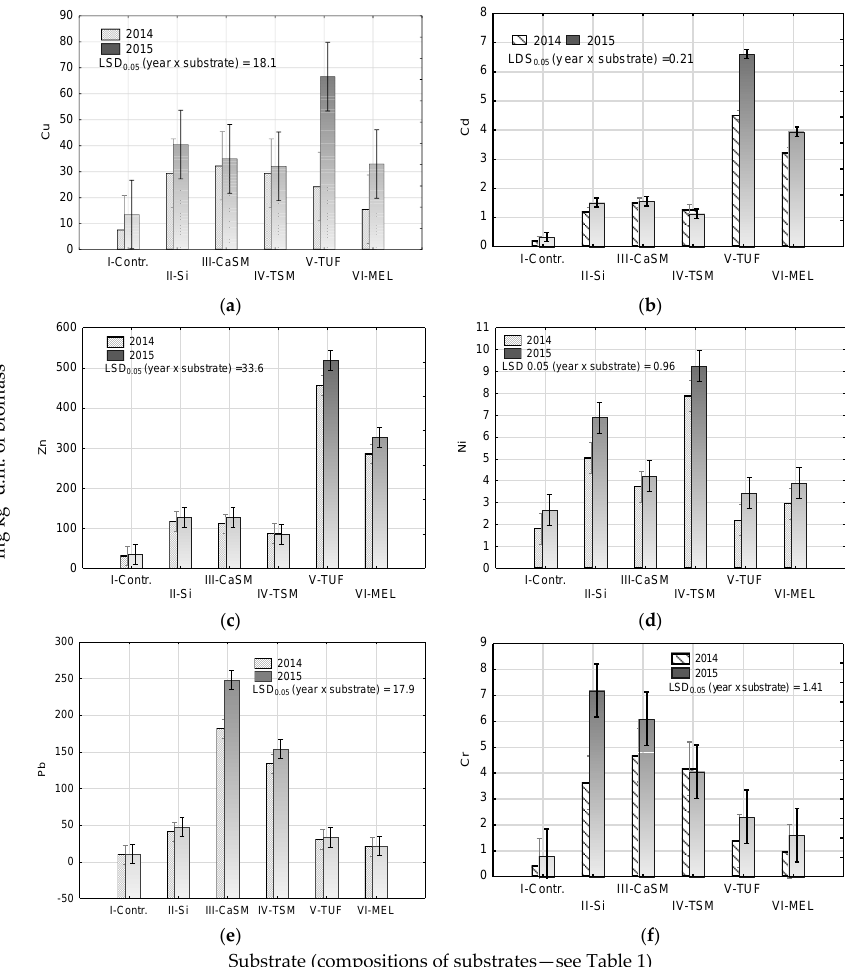
Figure 3. Trace element ( a – f ) concentrations (mg kg −1 ) in six different green roof substrates during cultivation of Sedum acre L. in the two-year experiment. FLL [21,52] does not give the exact information about heavy metal limits in sub- strates. The results were compared with the maximum levels of heavy metals in agricul- tural and urban soils in Poland [53], the total concentrations of which are the following (mg kg −1 ): 150 Cu, 300 Zn, 4 Cd, 100 Ni, 100 Pb, and 150 Cr. Only two substrates have not meet these guidelines: III-CaSM with too high contents of Zn (488 mg kg −1 ), Cd (5.6 mg kg −1 ), Pb (215 mg kg −1 ) and IV-TUF with Pb (144 mg kg −1 ). In all substrates, the level of strontium after two years of the experiment was in the range of 24–42 mg Sr kg −1 , and the control was not characterised by the lowest amount of it. The high concentration of toxic metals might inhibit plant growth, reduce the content of chlorophyll, and damage root systems [43]. However, alkaline soil reaction limits the